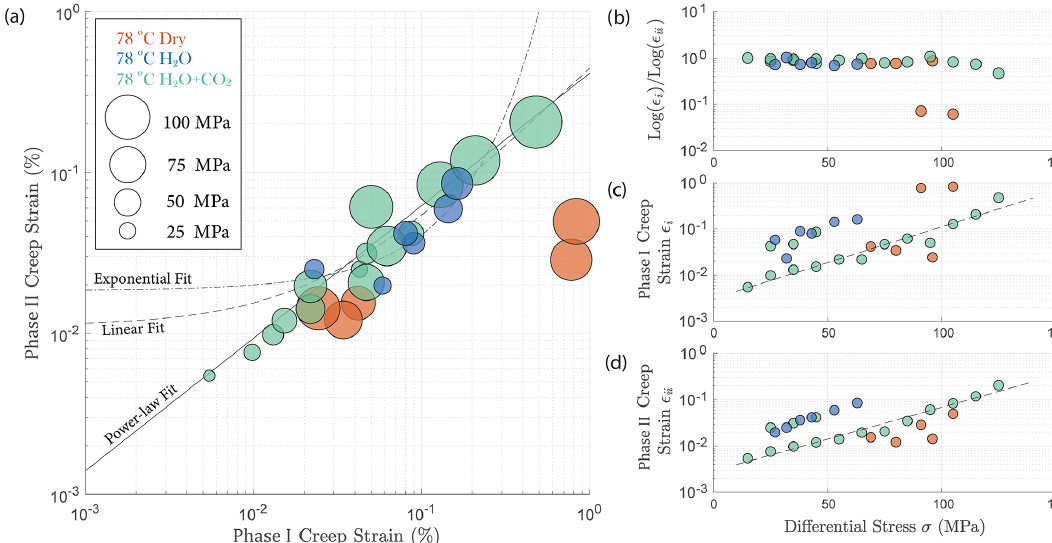
Figure 4. (a) Relationship between total phase I creep strain and phase II creep strain ∼ 24h after the stress step loading. The creep stress level is reflected by the size of the circles; (b) ratio between the logarithmic total phase I and logarithmic phase II creep strain remains constant and is independent of stress; the cumulated (c) phase I and (d) phase II creep strain is exponentially dependent on the creep stress. The fitted lines are calculated based on the data obtained from the H 2 O + CO 2 open experiment